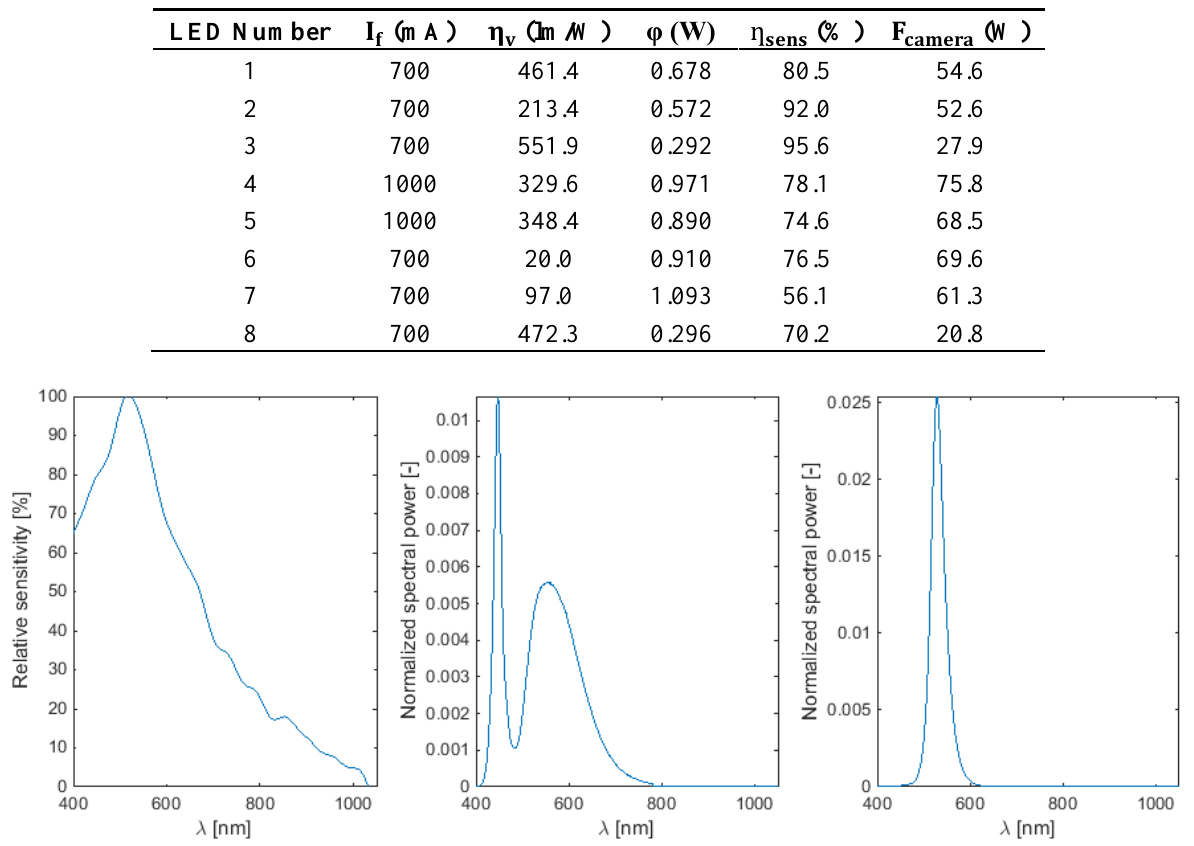
Table 4. Radiant to luminous flux conversion factor η current 𝐼 ), camera spectral efficiency factor ƞ 𝑓 for different LEDs. F camera